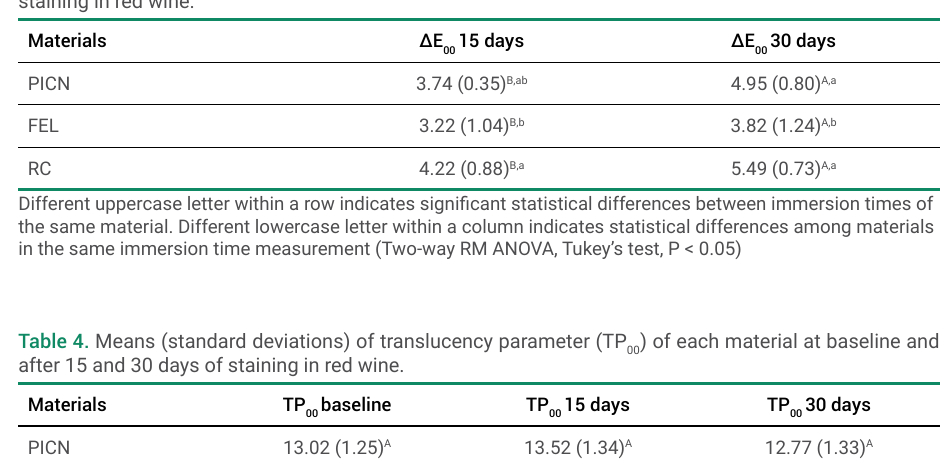
) of each material after 15 and 30 days of 00